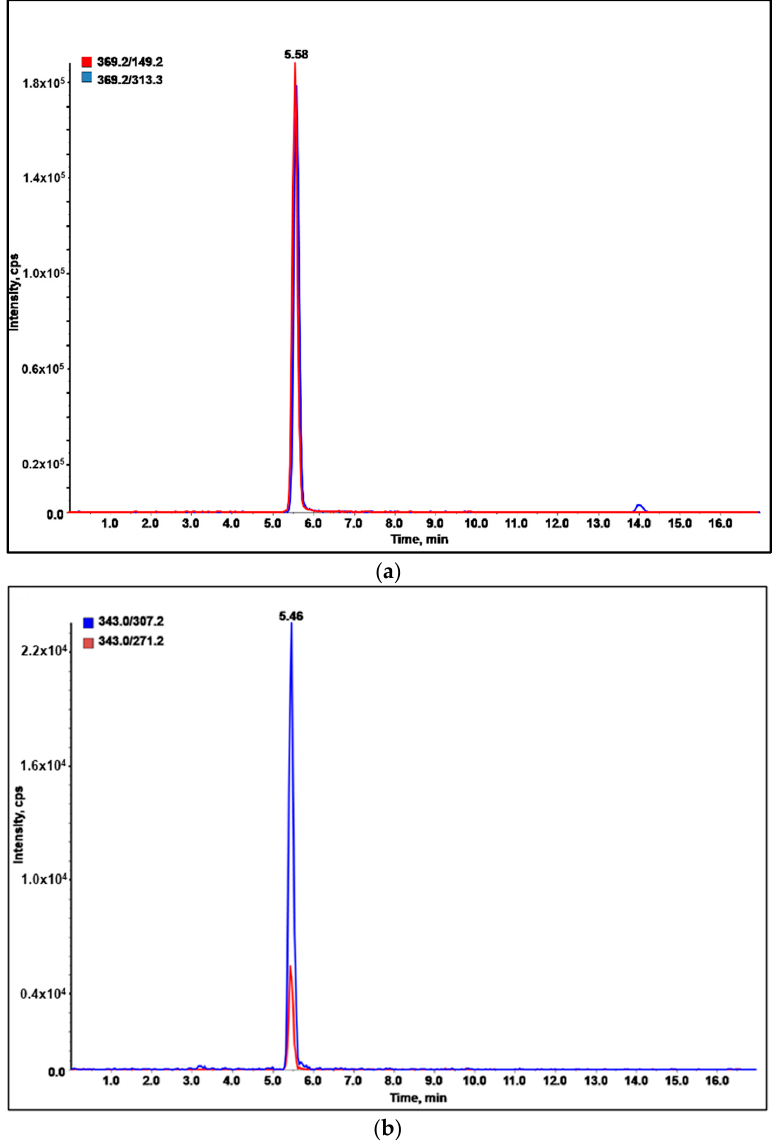
Figure 3. LC-MRM profile of: ( a ) methoxyfenozide in rosé wine; ( b ) boscalid in Prosecco wine.